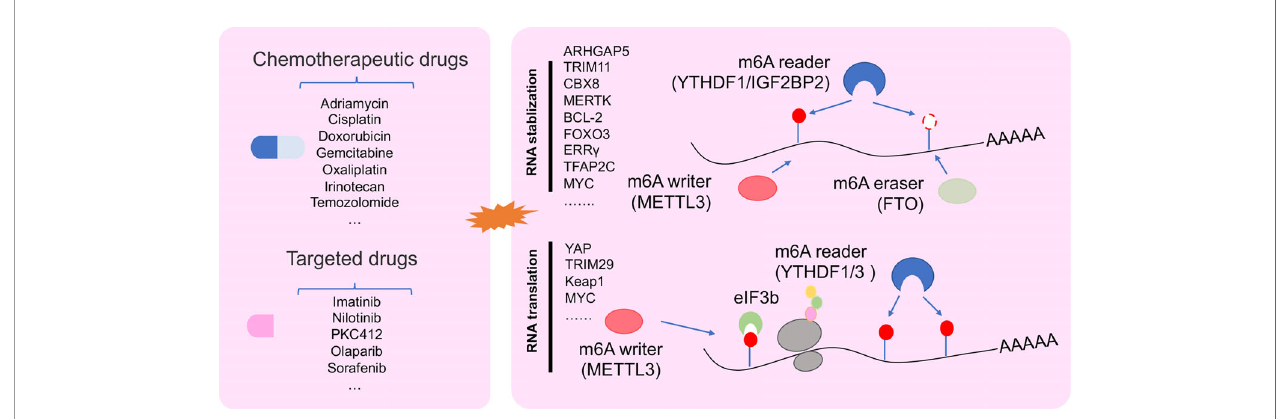
FIGURE 3 | The regulatory mechanism of m6A regulator in drug resistant cancer. m6A modi fi cation in drug resistant cancer cell was involved in changing RNA stability, and